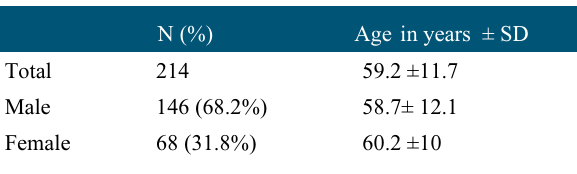
Table 1: Age and gender distribution of ST-segment elevation MI